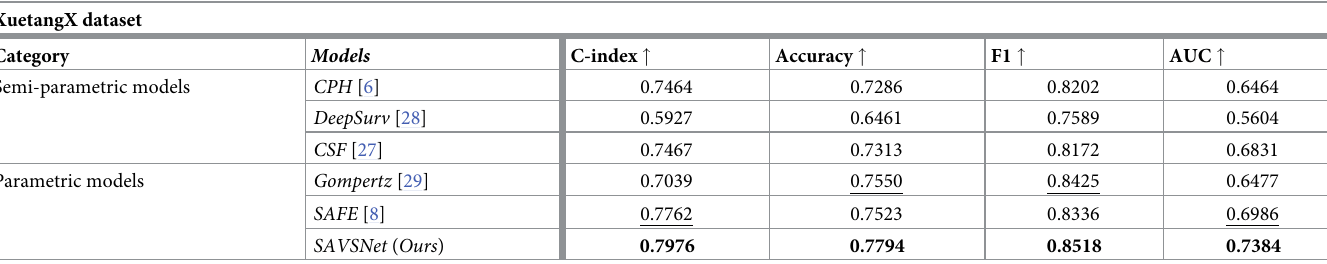
Table 3. The results on XuetangX